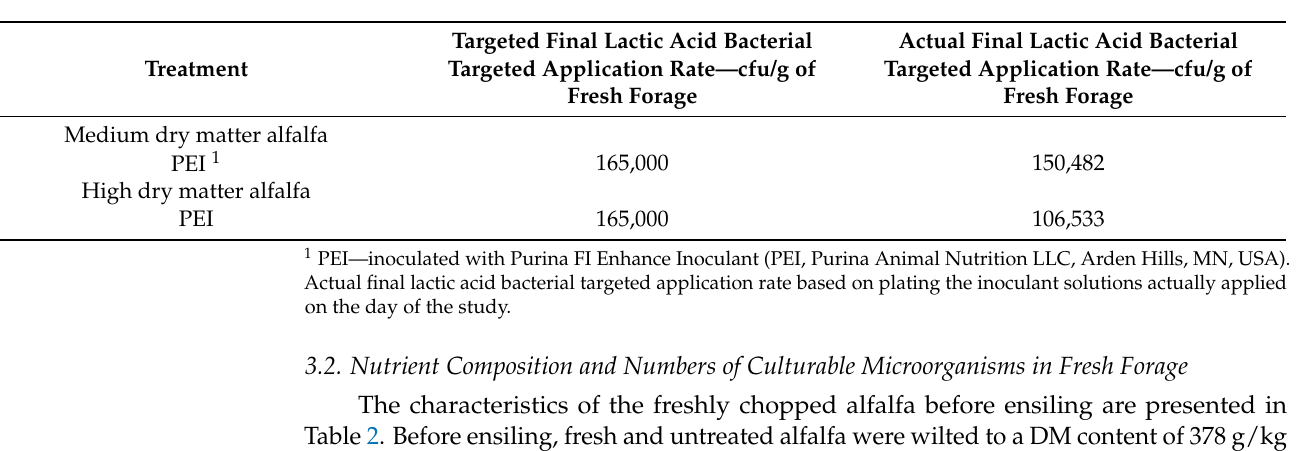
Table 1. Targeted and actual final lactic acid bacteria application